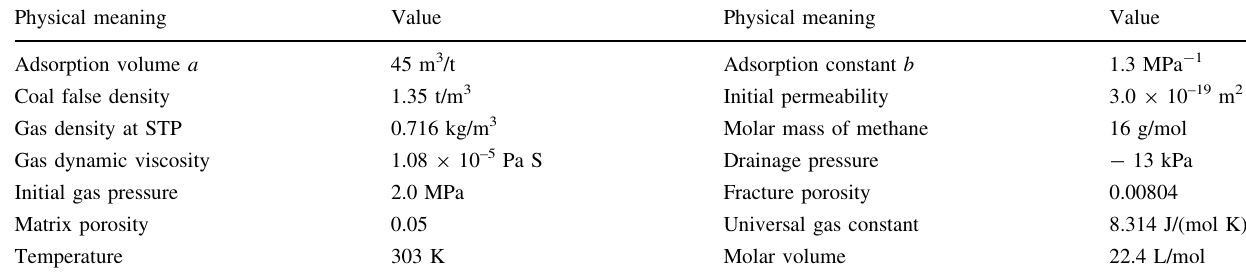
Fig. 3 Simplified geometric model and boundary settings Table 1 Parameter settings (An et al. 2013; Gong et al.